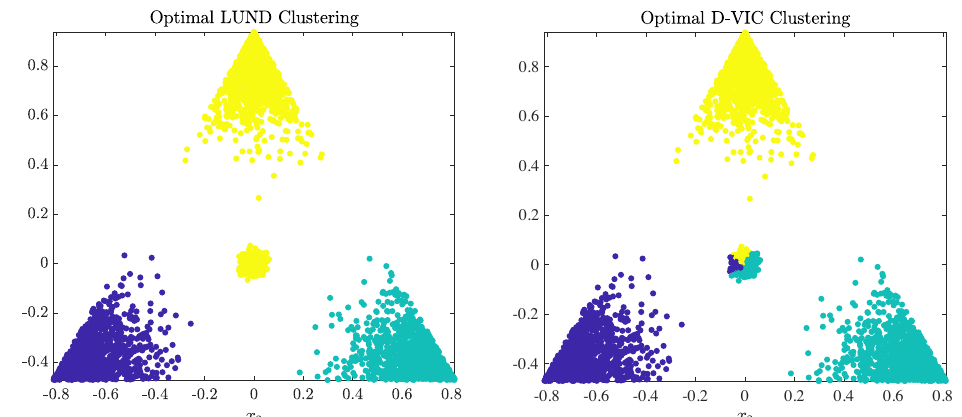
Figure 4. Optimal LUND (OA = 0.739) and D-VIC (OA = 0.905) clusterings of the synthetic